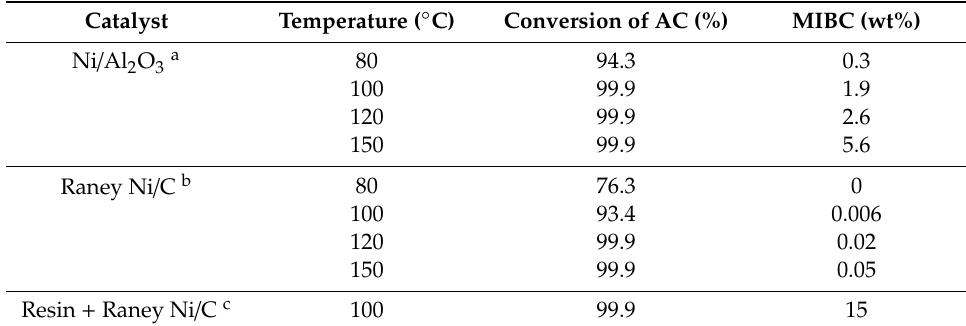
Table 1. Numerical results of acetone hydrogenation catalyzed by Raney Ni / C, Ni / Al 2 O 3 , and mixed catalyst of Raney Ni / C and strong acidic cation exchange